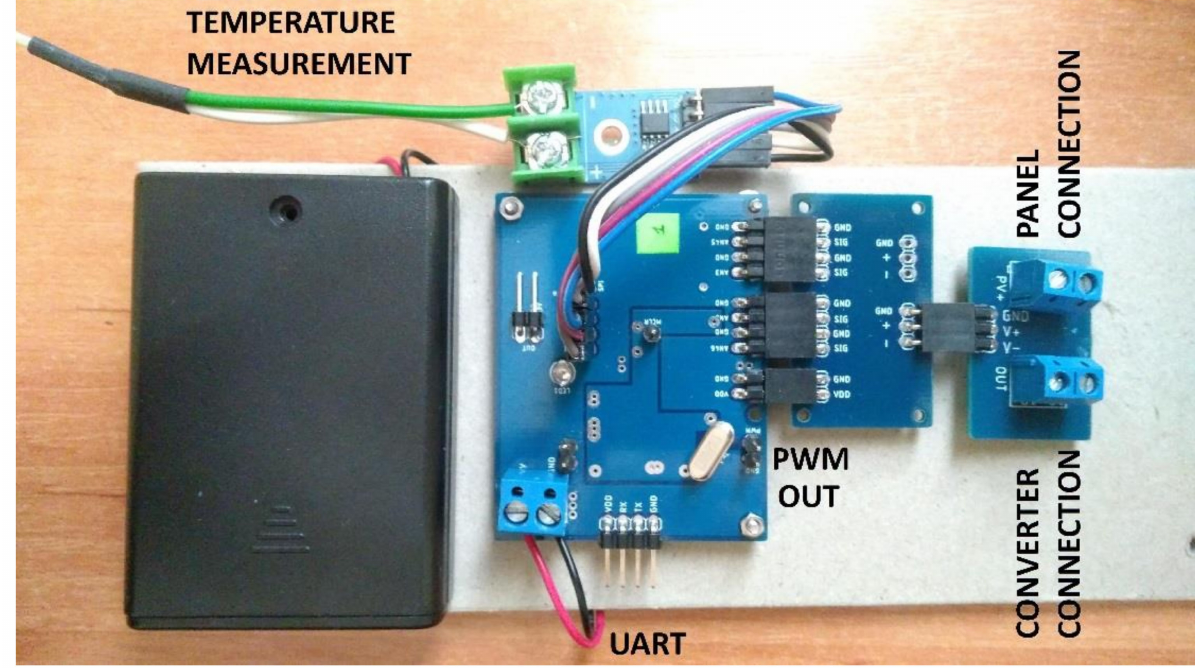
Figure A5. A measuring system incorporating a PIC32MZ microcontroller, used to control the buck converter and measure the input current, input voltage, and temperature of the